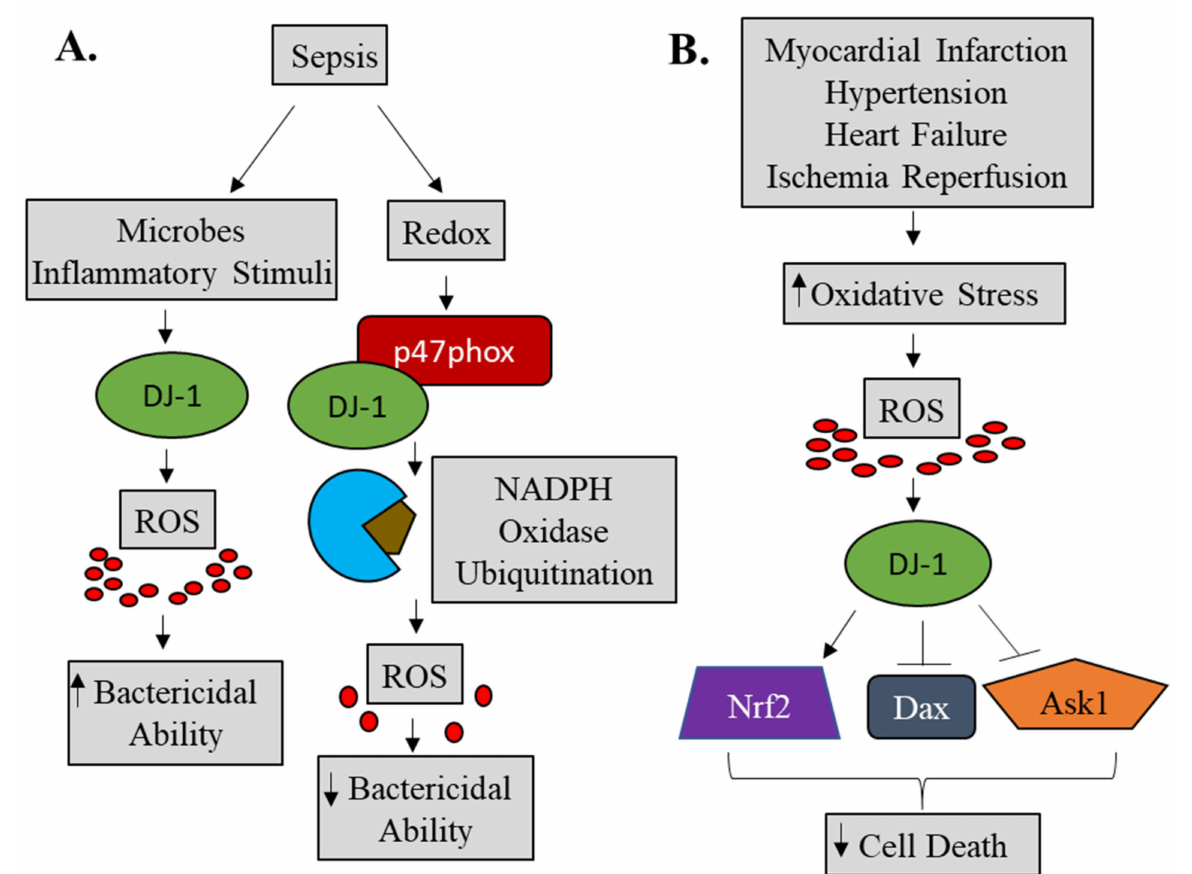
Figure 6. Schematic of DJ-1’s potential role in sepsis and cardiovascular disease. Our data are summarized in this schematic diagram. In innate immune cells, following an inflammatory or bacterial stimulus, DJ-1 expression is increased. Available DJ-1 can regulate bactericidal activity by directly scavenging superoxide ions and reducing ROS. Alternatively, in the redox state, DJ-1 may bind to p47phox and disrupt NADPH oxidase complex assembly, or ubiquitinate NADPH oxidase, subsequently leading to decreased ROS production ( A ). In response to an increase in oxidative stress, DJ-1 can exert antioxidant function by upregulating Nrf2 activation and downregulating pro-apoptotic Dax and Ask1 ( B ). Nrf2, NF-E2 related factor-2; ASK1, apoptosis signal-regulating kinase 1; Daxx, death-associated protein